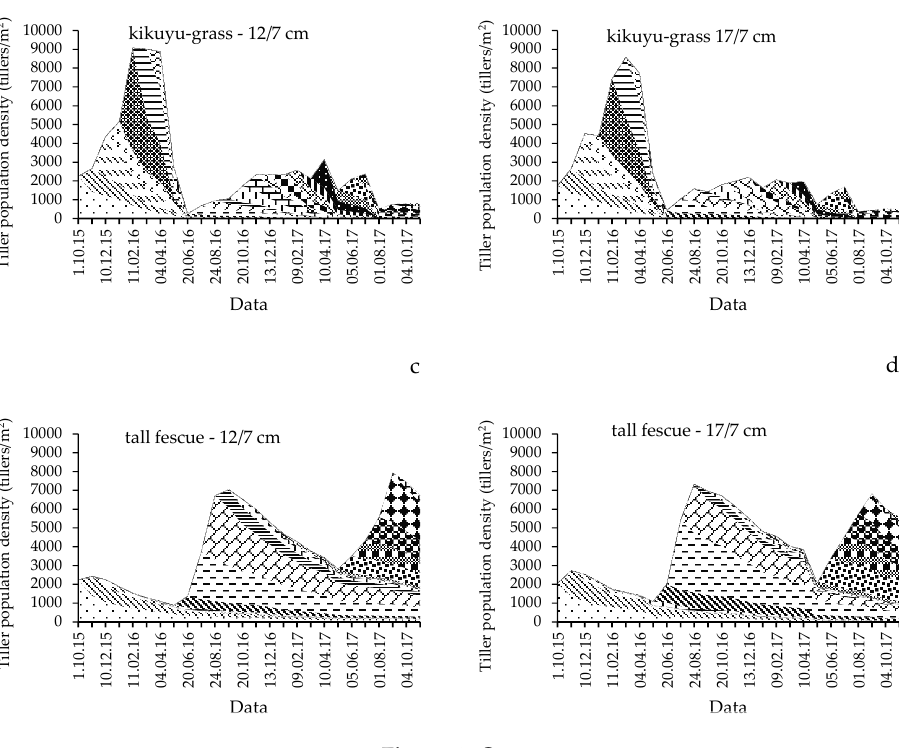
Figure 4. Cohort survival diagrams for tillers of kikuyu-grass ( a, b ) and tall fescue ( c, d ) cultivated in mixed canopies maintained at 12 and 17 cm and submitted to a single grazing to 7 cm in mid-autumn and their overlapping population demography ( e, f ). 4. Discussion The canopy heights were kept close to the intended targets during the entire experimental period. The hypothesis that a single autumn grazing to 7 cm would change tillering dynamics was rejected, once the total (and tall fescue) tiller populations were similar between canopies subjected or not to an autumn grazing to 7 cm (Table 4). The isolated effect of grazing management based on canopies ’ heights generated unique effects on the tillering dynamics for each species. The number of tillers of tall fescue appearing in each cohort, and its longevity, were practically insensitive to such management variations, except in those maintained at 7 cm. The tall fescue can be classified as a